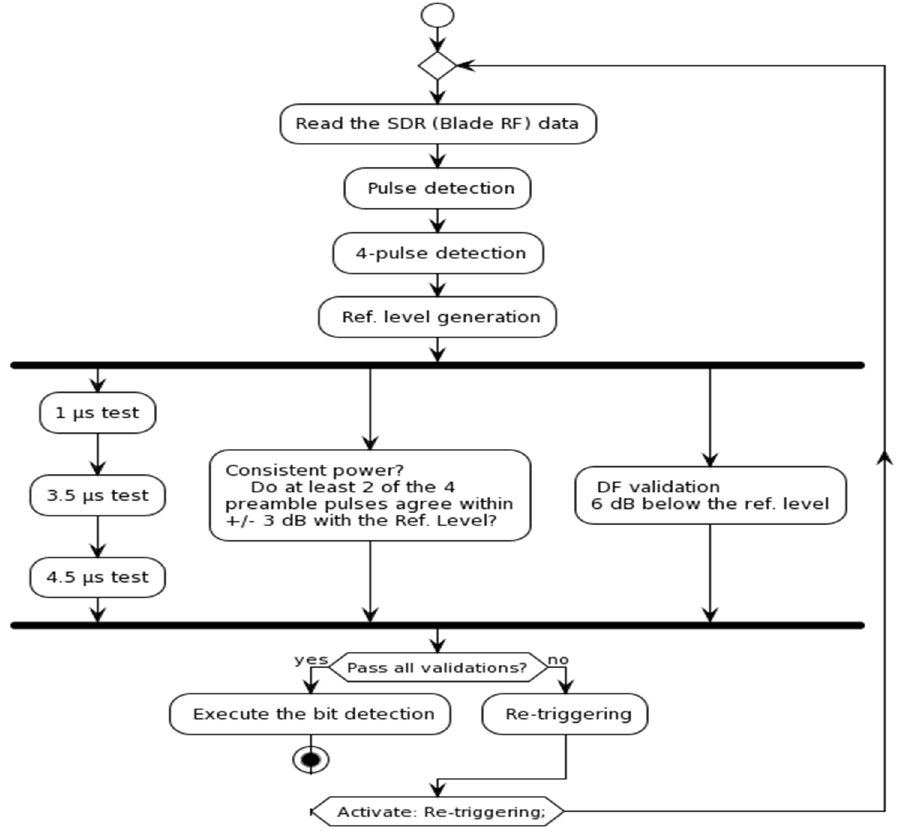
Figure 3. Enhance the preamble detection procedure .